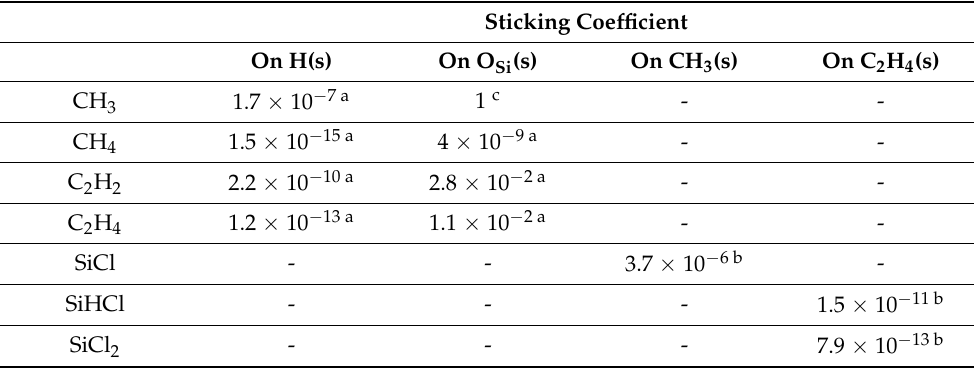
Table 3. Sticking coefficient of intermediate species on surface site or adsorbed species.